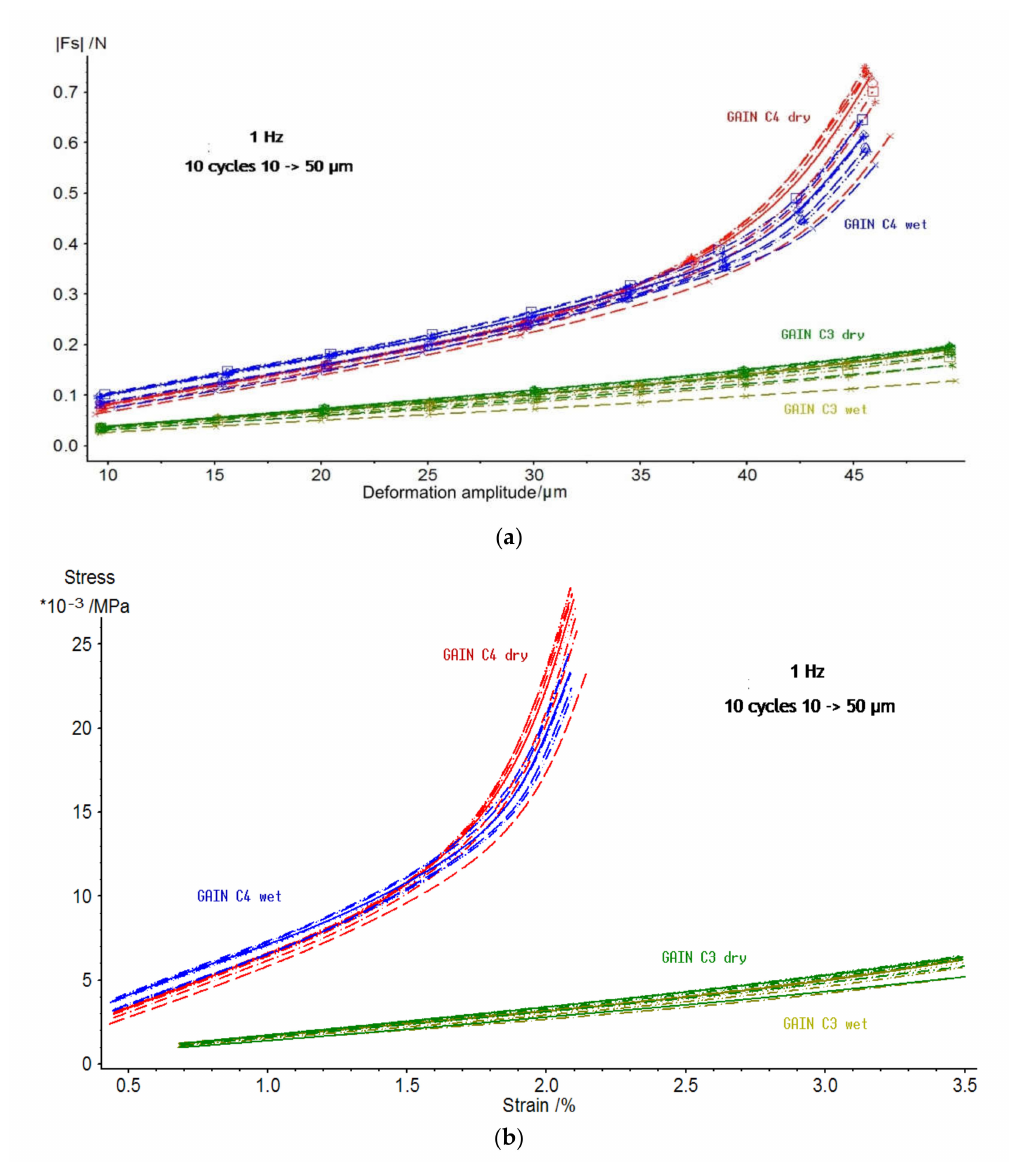
Figure 4. ( a ) Dynamic force (N) vs. dynamic deformation ( µ m) for C3 and C4 GAIN scaffolds in dry and wet (immersed conditions; ( b ) data of figure ( a ) converted into compressive stress and true strain expressed in % to the starting thickness of the